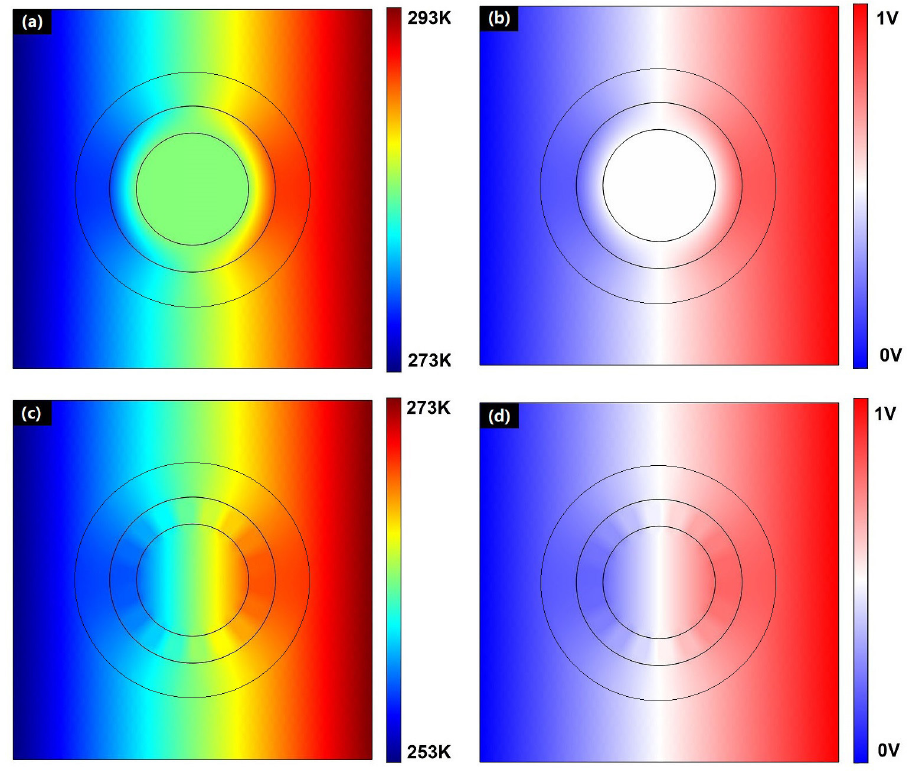
Figure 3. Finite-element simulation results of the temperature/voltage distributions in the structure displayed in Figure 2. ( a ) the temperature distribution of the cloak state; ( b ) the voltage distribution of the cloak state; ( c ) the temperature distribution of the concentrator state; ( d ) the voltage distribution of the concentrator